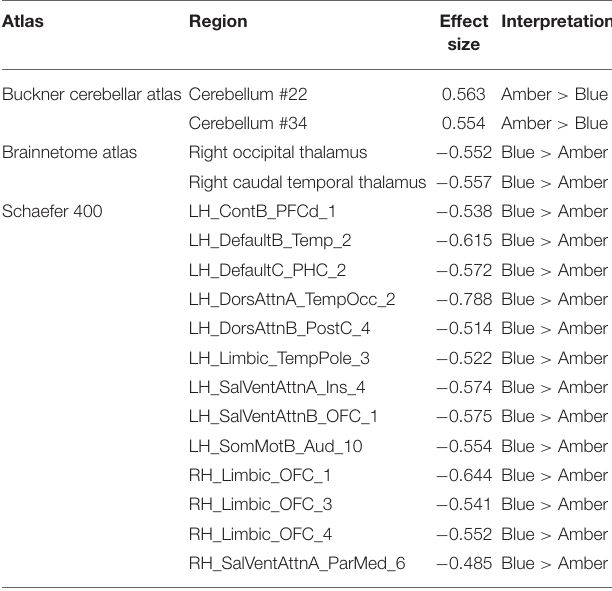
TABLE 1 | Regions of interest demonstrating baseline-adjusted differences in gray matter volume. Atlas